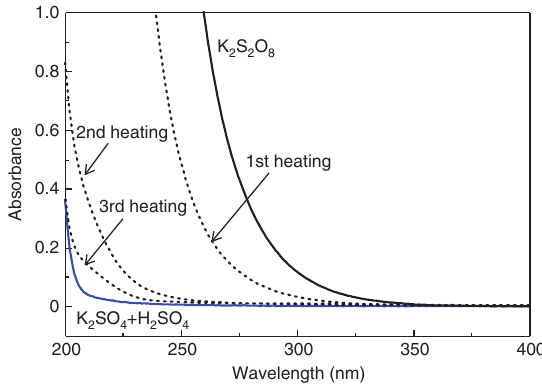
S O 2 2 8 SO ) 2 4 S O 2 2 8